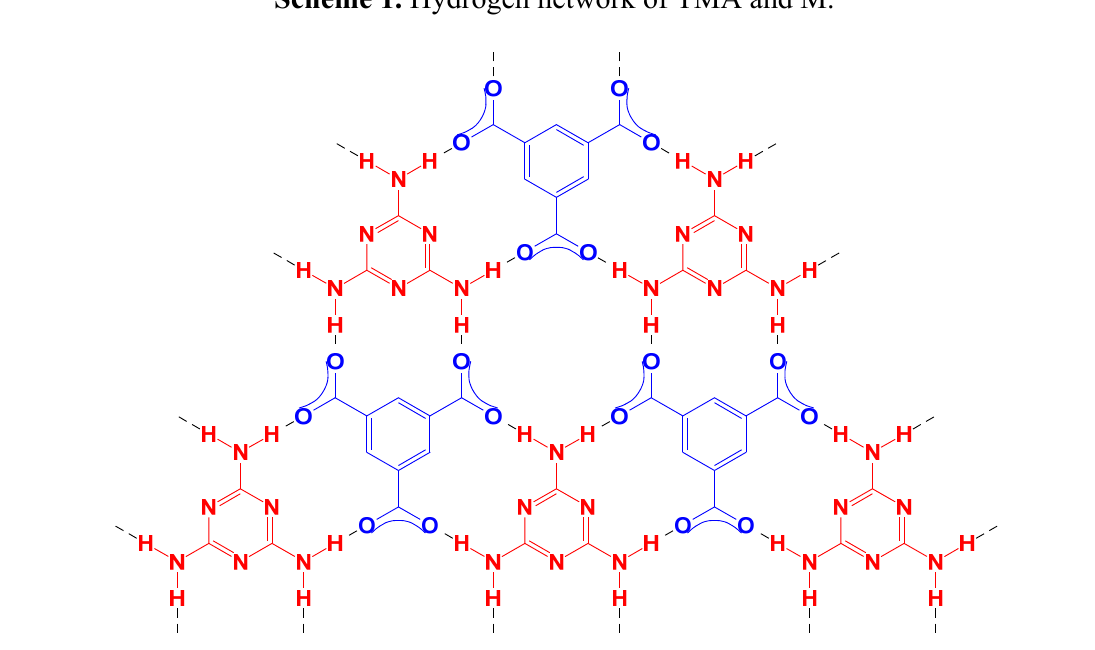
Scheme 1. Hydrogen network of TMA and